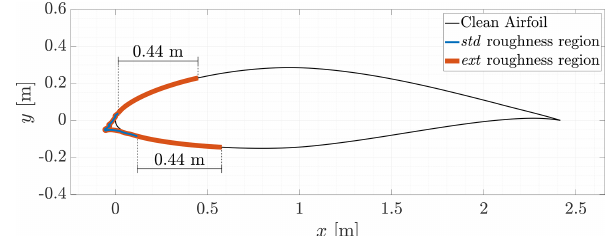
Figure 4. Definition of the std and of the ext roughness regions on an iced airfoil. The std region corresponds to the numerically com- puted ice shape. The ext region includes the std region and extends for 0.44m beyond the impingement limits of the ice shape, regard- less of the chord of the airfoil. On Section B, this corresponds to 18% of the chord.